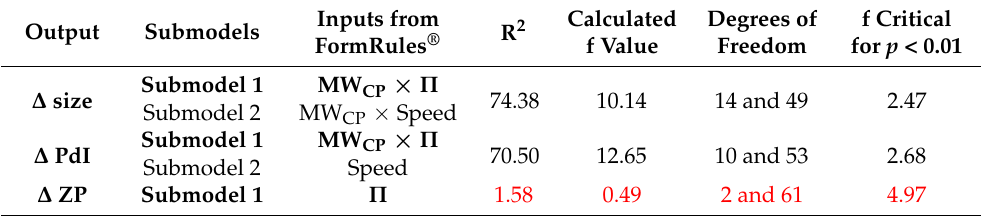
Table 3. Inputs selected by NFL models that explain ∆ Size, ∆ PdI, and ∆ ZP in lyophilized NLCs’ formulations, along with predictability (R 2 ) and ANOVA parameter (f: critical value of the f dis- tribution). The most relevant submodel is bolded, while models not meeting quality criteria are highlighted in